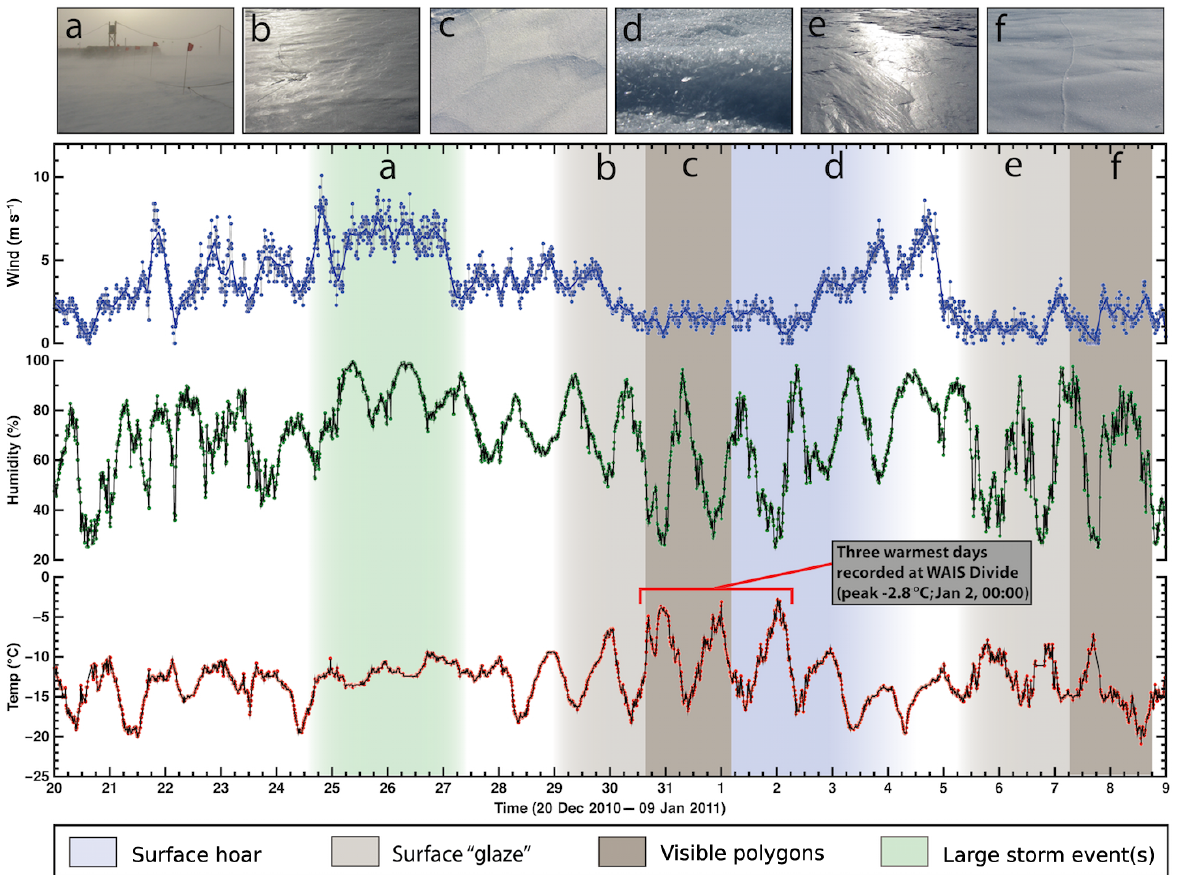
Figure 6. Surface evolution over 20 days in the 2010–2011 season, and AWS data. Shading shows episodes of surface hoar, glazes, and polygonal cracking; storm events are also shown. Letters near the top refer to photographs above of specific features or events. All dates and times are GMT (WAIS local time − 12h). The errors for all AWS instruments are listed in Table